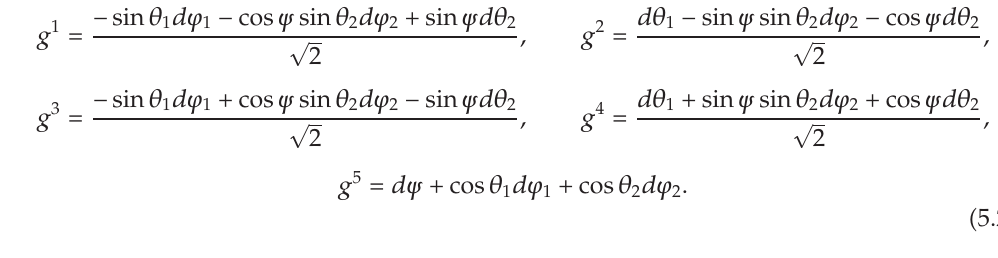
the singular conifold case (cid:3) 43 (cid:4) , which we wrote in (cid:5) 2.14 (cid:6) . The complex mass parameter m in W is mapped to the geometrical parameter μ . The di ff erent fields are summarized in the quiver diagram of Figure